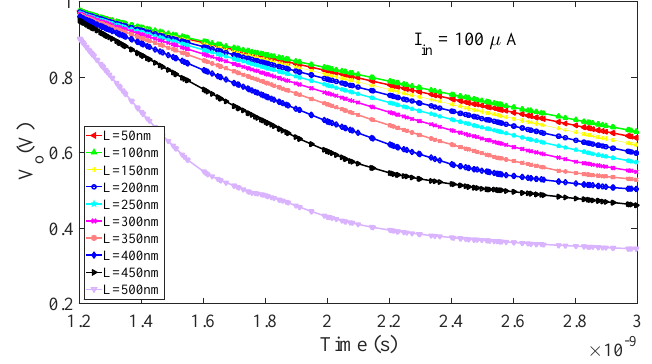
Figure 6. Sizing of the M3